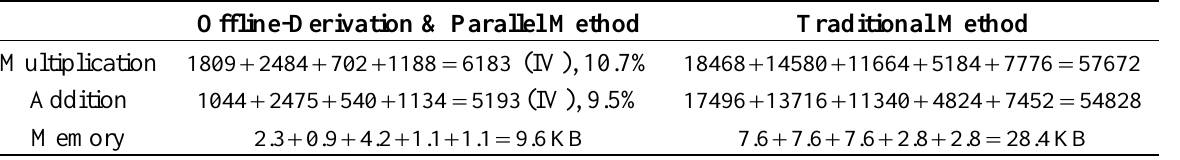
Table 7. Optimization efficiency of offline-derivation and parallel method.